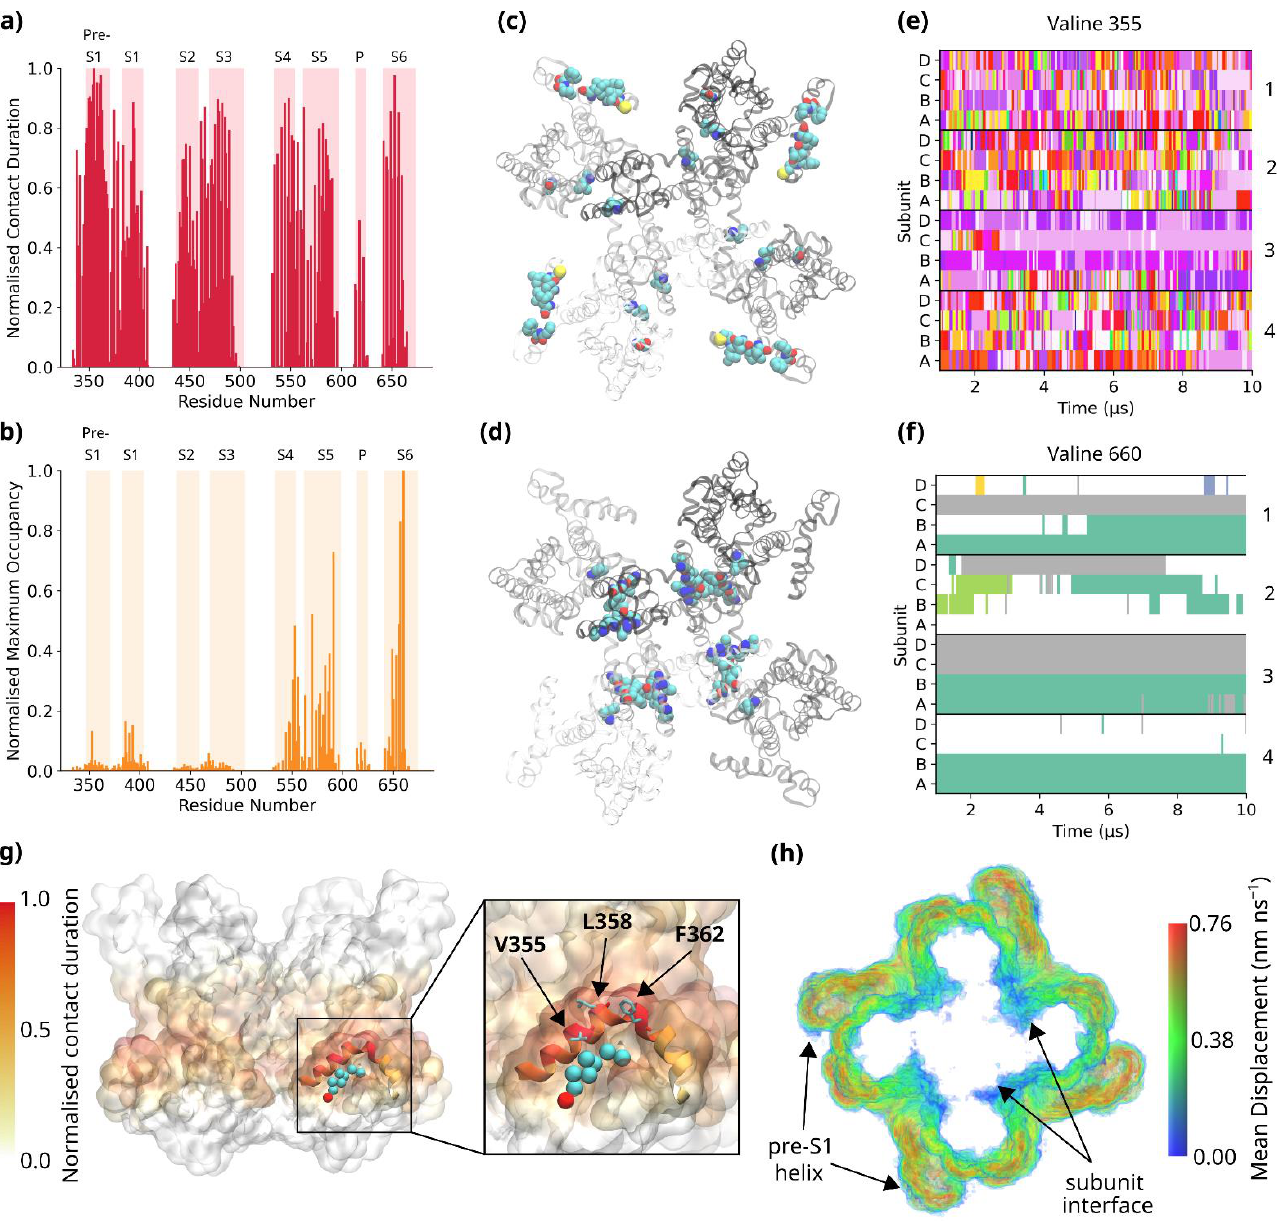
Figure 3. ( a ) Normalised contact duration values for TRPC3 interaction with cholesterol. The values are normalised with respect to Val-355, the residue with the highest average contact duration. All values are averaged across 16 monomers. The transmembrane helices of TRPC3 are indicated in light pink. ( b ) Normalised maximum occupancy values for TRPC3 interaction with cholesterol. The values are normalised with respect to Val-660, the residue with the greatest maximum occupancy value. All values are averaged across 16 monomers. The transmembrane helices of TRPC3 are indicated in light orange. ( c ) The ten residues of TRPC3 with the highest contact duration values, shown in cyan (carbon), red (oxygen), blue (nitrogen) and sulphur (yellow). The monomers of TRPC3 are shown in greyscale. ( d ) As in ( c ), for maximum occupancy. ( e ) Eventplot showing cholesterol interaction with Val-355. Every cholesterol binding event is represented by a different colour. ( f ) Eventplot showing cholesterol interaction with Val-660. ( g ) The three-dimensional structure of TRPC3, with residues coloured according to the contact duration values in ( a ). The pre-S1 helix is shown in cartoon representation, with a cholesterol bound under its arch-like structure. In red is the hydroxyl bead of Chol, in cyan are the remaining sterol and hydrocarbon tail beads. The zoom-in view highlights the hydrophobic residues on the pre-S1 helix. ( h ) Displacement map showing the mean displacement (nm ns −1 ) of cholesterol molecules within 0.6 nm of TRPC3.